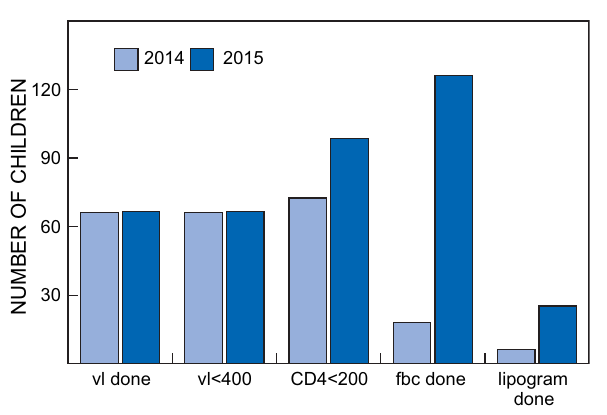
(2014).[m, p, pt, tc, gw, pt, bt, l and st are clinic abbreviations for anonymity] Figure 5: Normal weight for age in one subdistrict